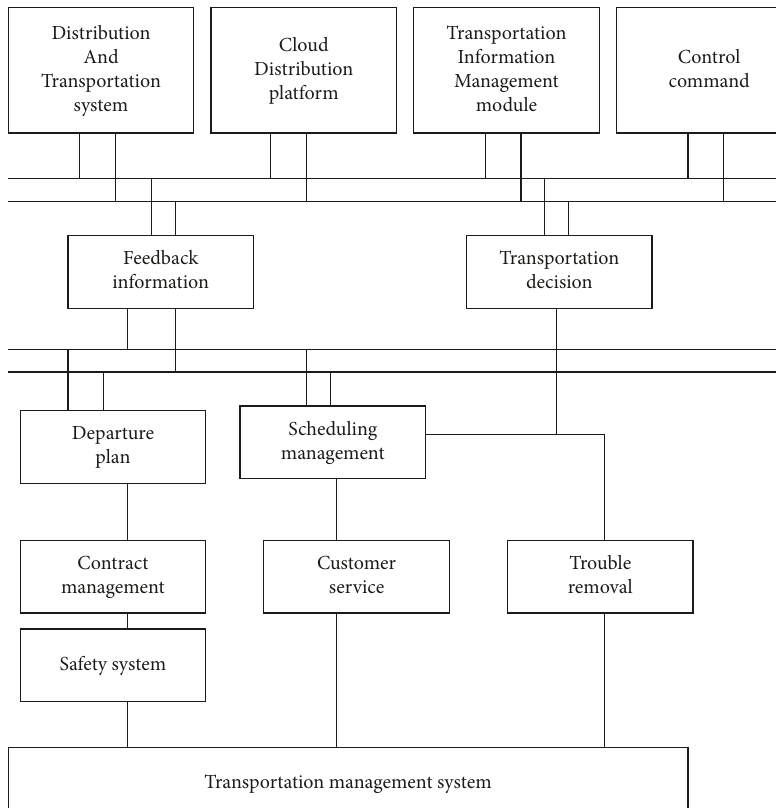
Figure 6: Cloud distribution transportation management